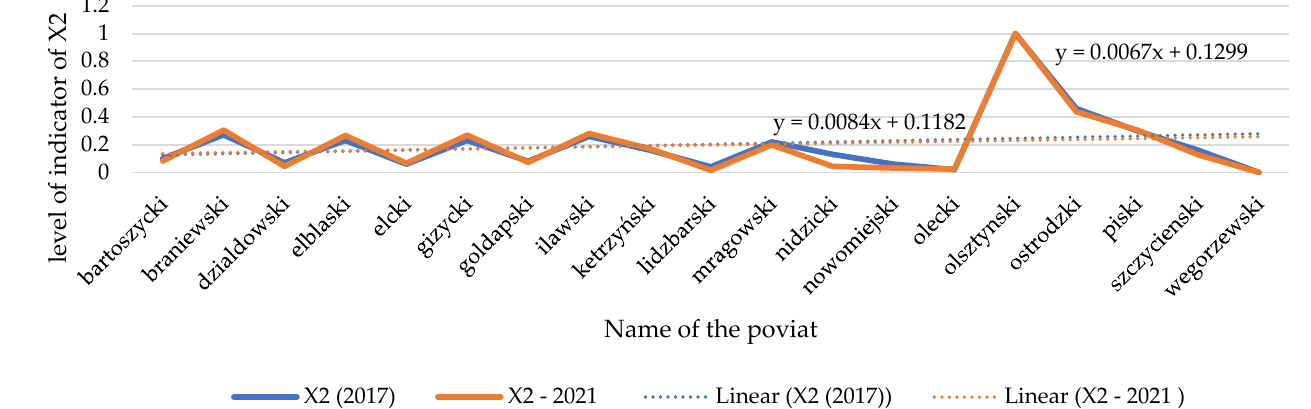
Figure 12. Changes in the index of the number of extreme weather phenomena and weather anomalies in the spatial units under study (X2). Source: own study.